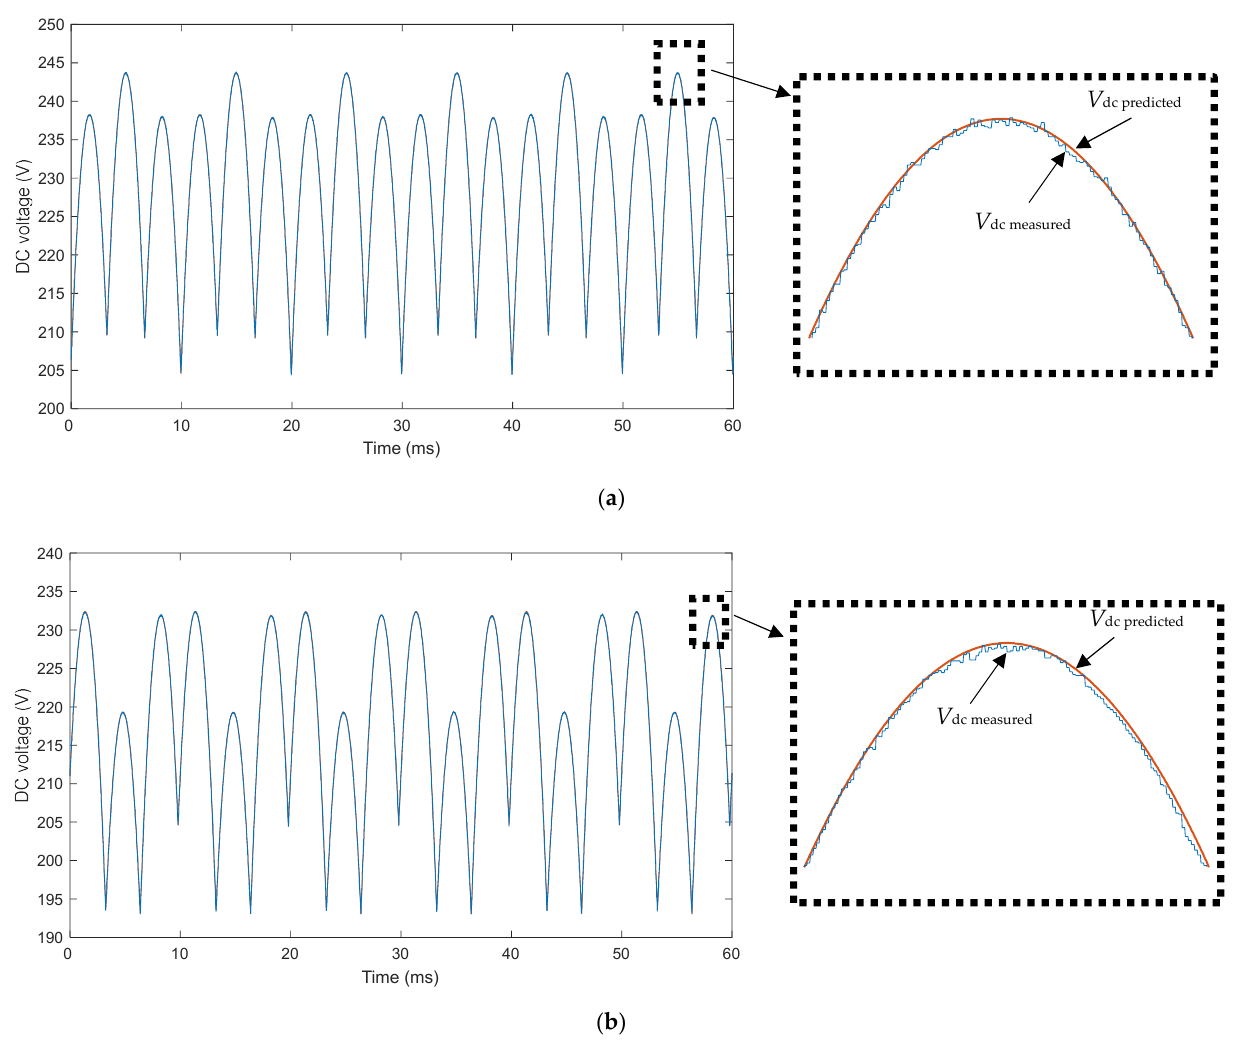
Figure 8. Measured DC voltage and predicted DC voltage by the smart sensor. ( a ) Case 1: one-phase voltage drop of 5% (phase a) with respect to its rated value ( h = 0.95); ( b ) two-phase voltage drop of 10% (phases b and c) with respect to its rated value ( h = 0.9). Legend: solid blue line: measured DC voltage; solid red line = predicted DC voltage by the smart